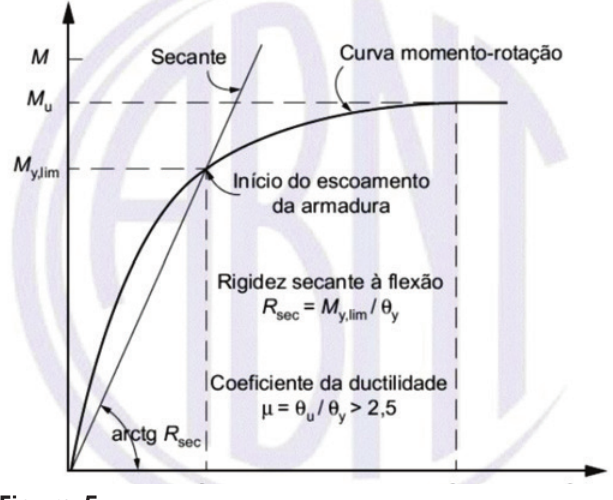
ABNT NBR 9062 [24] incorporou a semirrigidez das ligações pré- -moldadas por meio do fator de restrição à rotação . R O fator de restrição à rotação consiste na relação entre a rota- α ção da extremidade do elemento (θ1) e a soma da rotação da extremidade do elemento (θ ) com a rotação da ligação (θ ), 1 2 conforme Figura 4. A ABNT NBR 9062 [24] apresenta a Equa- ção 1 para determinar o valor de αR. Esta expressão associa a rigidez à flexão da ligação viga-pilar (Rsec) com a rigidez da viga.